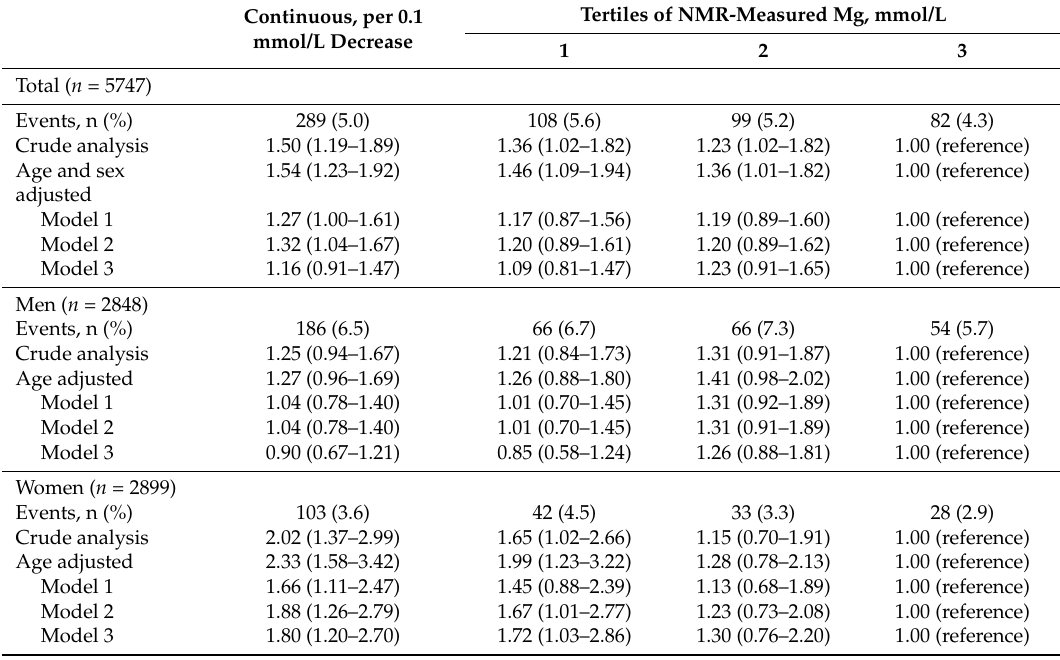
Table 3. The association of NMR-measured ionized Mg with the risk of developing type 2 diabetes mellitus (T2DM) in the PREVEND